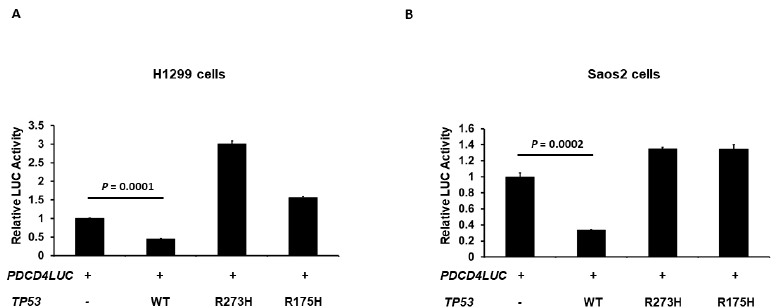
Figure 2. p53 down-regulates PDCD4 transcription. p53 reduces PDCD4 promoter activity in H1299 ( A ) and Saos2 ( B ) cells. Cells in a 24-well plate were co-transfected with either PDCD4 luciferase reporter plasmid or pGL4 empty vector and pRL-TK Renilla control vector, with or without p53 expression plasmids, by Fugene HD. After forty-eight hours of transfection, luciferase activities were analyzed by the Dual-Luciferase Reporter System and normalized to the control Renilla activity. Relative LUC activity was calculated and plotted. The protein levels of p53 in the cells from the reporter assays were confirmed using anti-p53 immunoblotting. The original WB can be found in Supplementary Material.